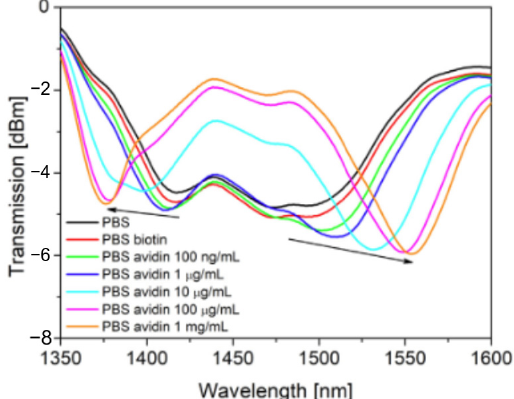
Figure 13. Transmission spectra for TaOx-coated LPG at different avidin concentrations. Reprinted with permission from [185].